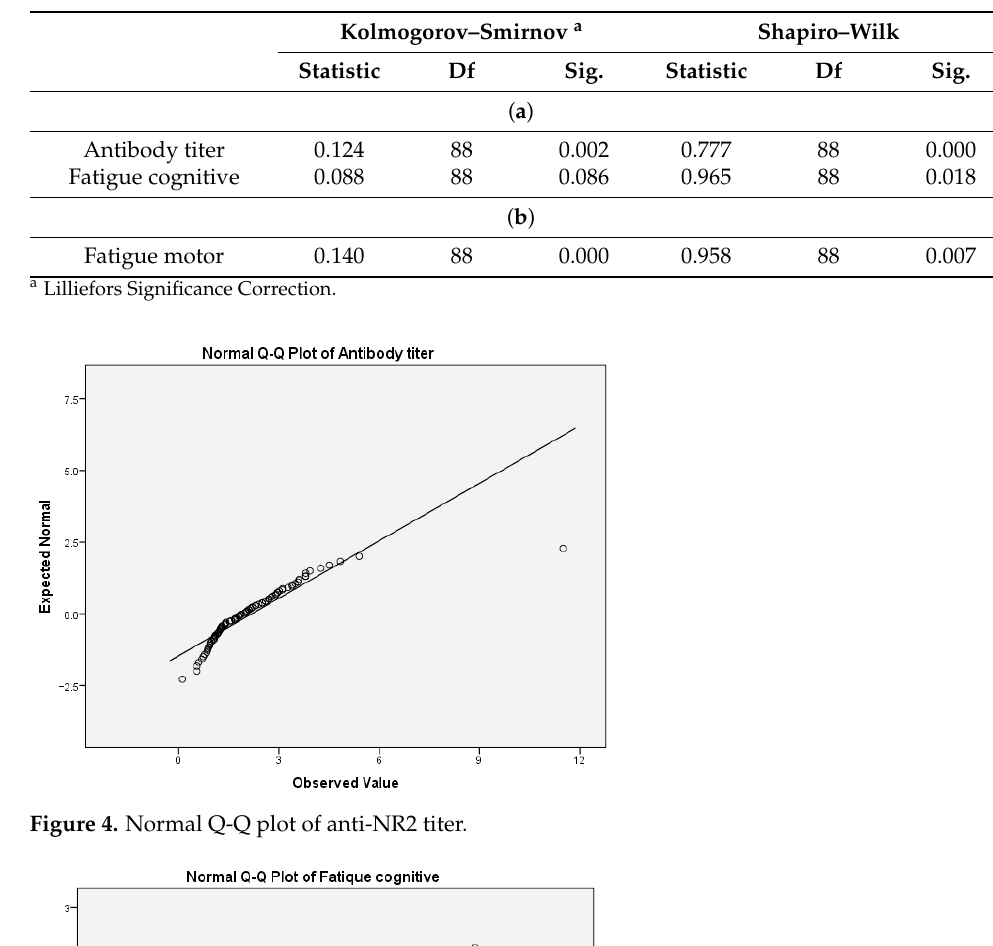
Table 9. ( a ) Tests of normality for cognitive fatigue. ( b ). Tests of normality for motor fatigue.